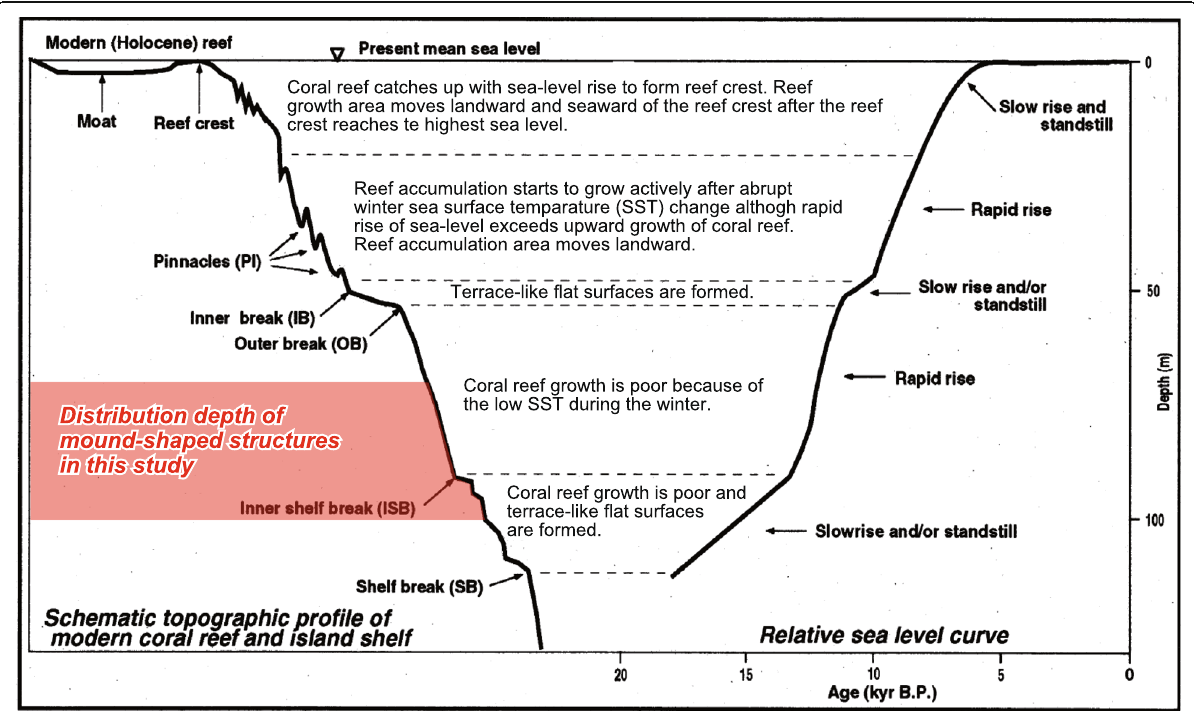
Fig. 3 Distribution depth of mound-shaped structures in this study and schematic geomorphic development of the island shelf after the Last Glacial Maximum in the central and southern Ryukyus (Hori and Kayanne 2000). This figure is modified from Hori and Kayanne